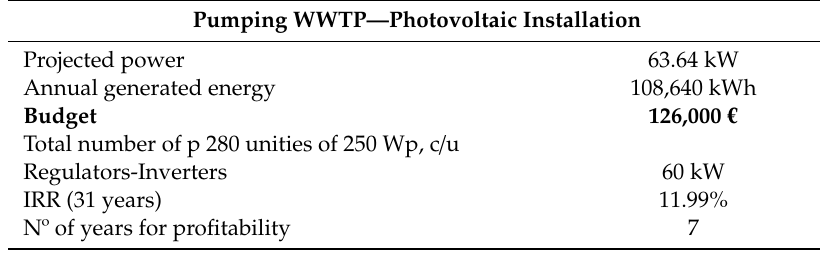
Table 8. Summary of the photovoltaic solar installation of the pumping at wastewater treatment